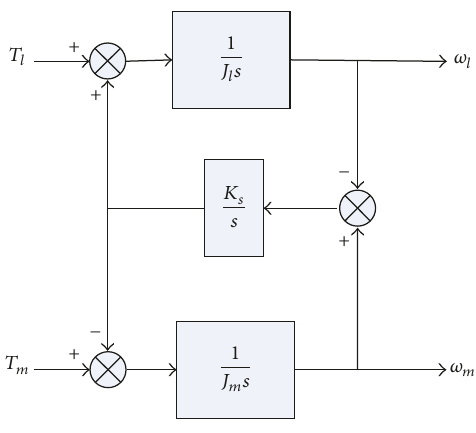
Figure 4: Block diagram of the two-mass